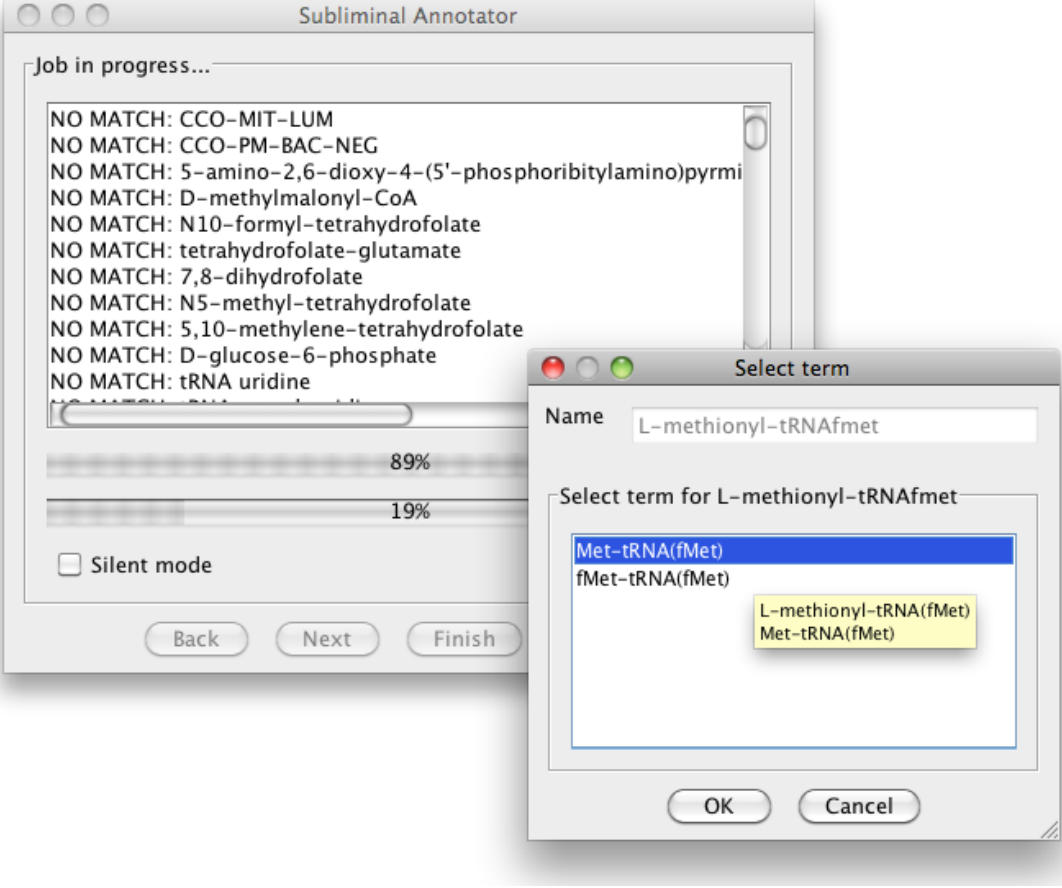
Figure 2: Screen capture of the SuBliMinaL Annotator. The main window displays progress of the annotation process, indicating terms that remain unmatched, and two progress bars displaying the percentage of terms successfully annotated and progress of the annotation process respectively. The foreground dialog box displays the results of a search for a metabolite name against ChEBI, ordered by the ChEBI Text Based Score. The user can select one of the two terms in order to annotate the metabolite. Compound synonyms are also searched, and can be viewed in a